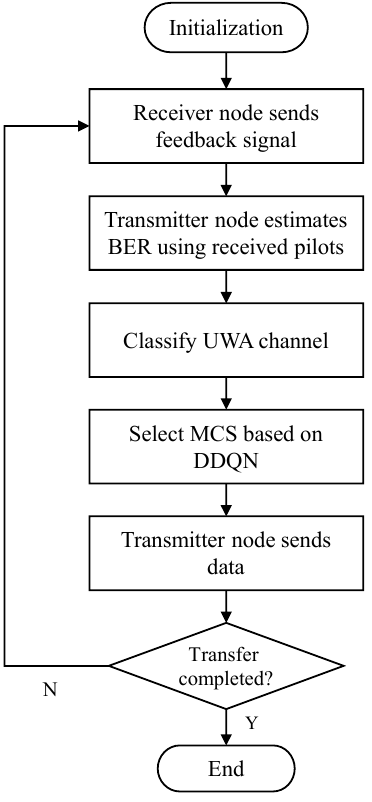
Figure 5. The flow chart of the proposed